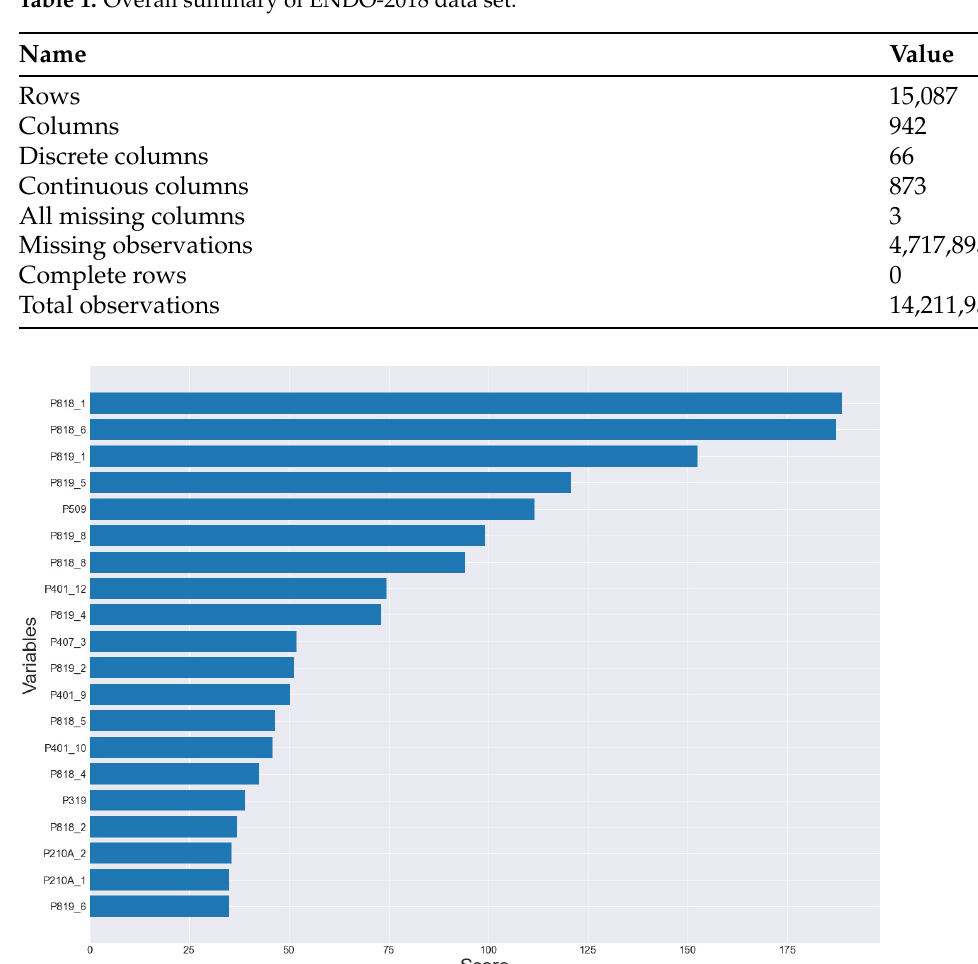
Figure 3. Chi-Square scores in the prediction of teacher job